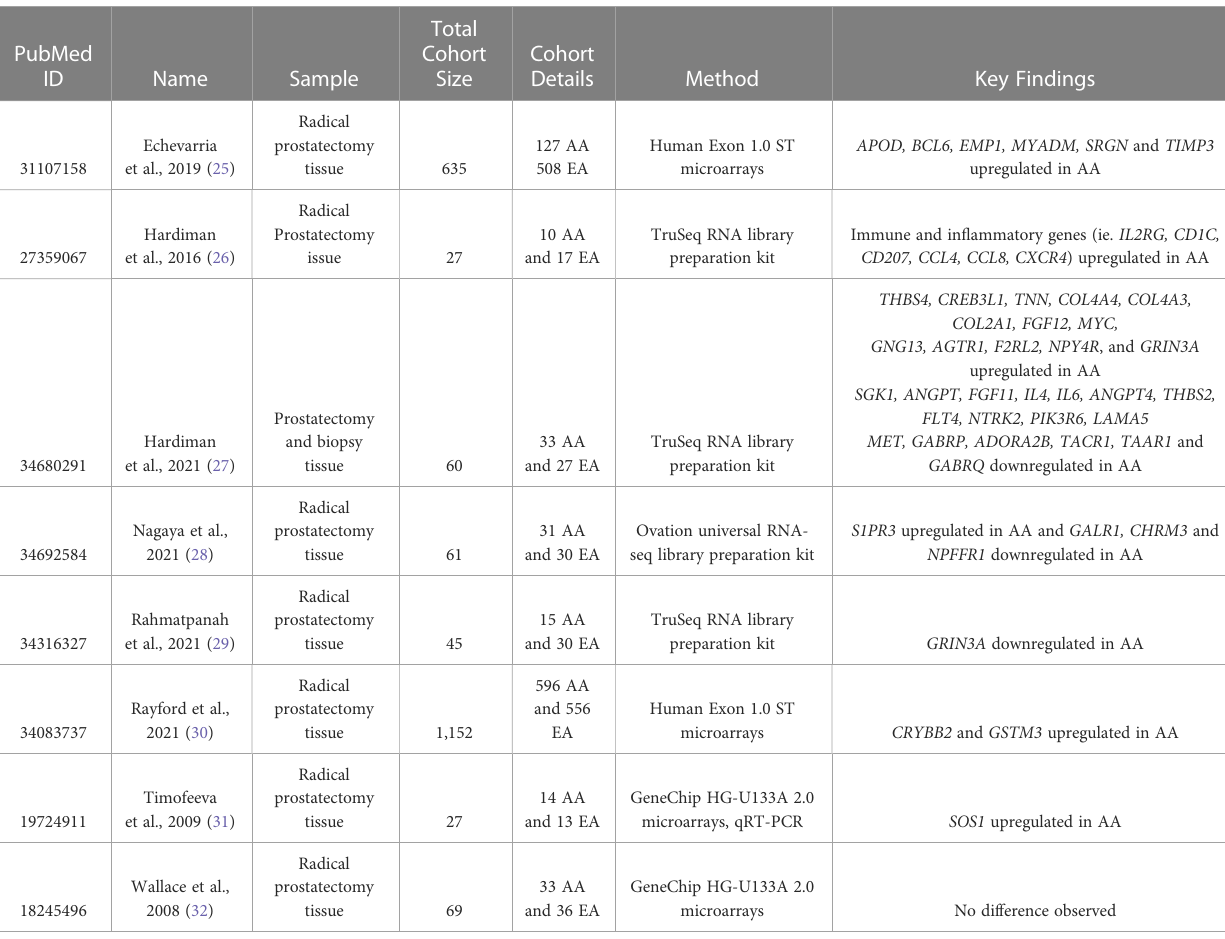
TABLE 3 Studies that compared transcriptomic features between AA and EA